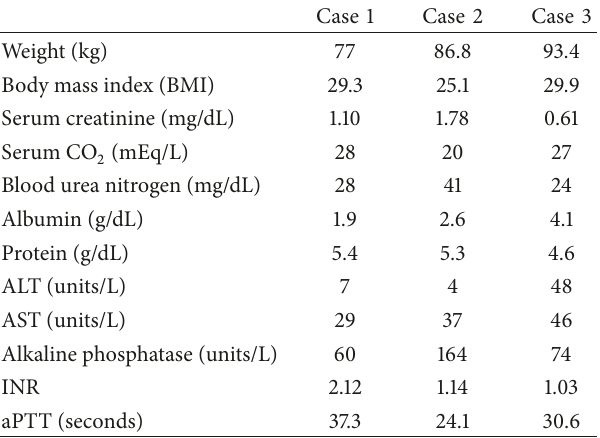
Table 1: Select demographic data and labs at time of